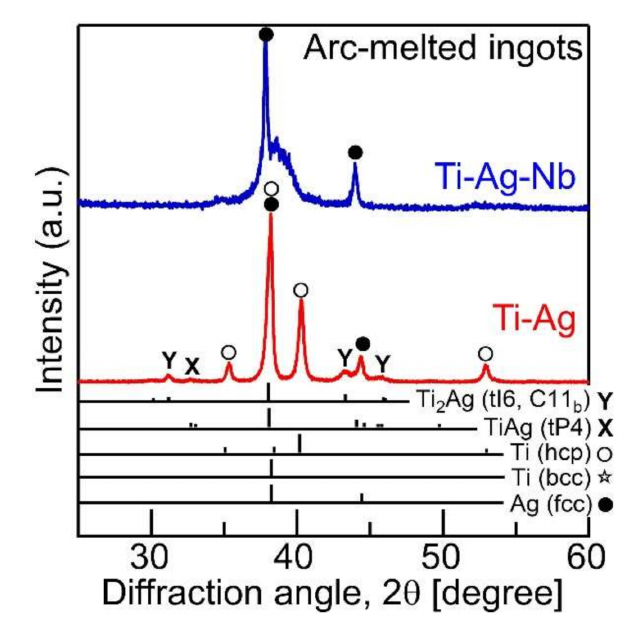
Figure 4. XRD patterns of the arc-melted ingots in the Ti 66.7 Ag 33.3 (Ti-Ag, red color, lower side) and Ti 53.4 Ag 33.3 Nb 13.3 (Ti-Nb-Ag, blue color, upper side)